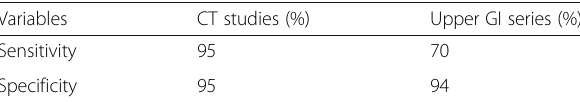
Table 5 Sensitivity and specificity of CT studies and upper GI